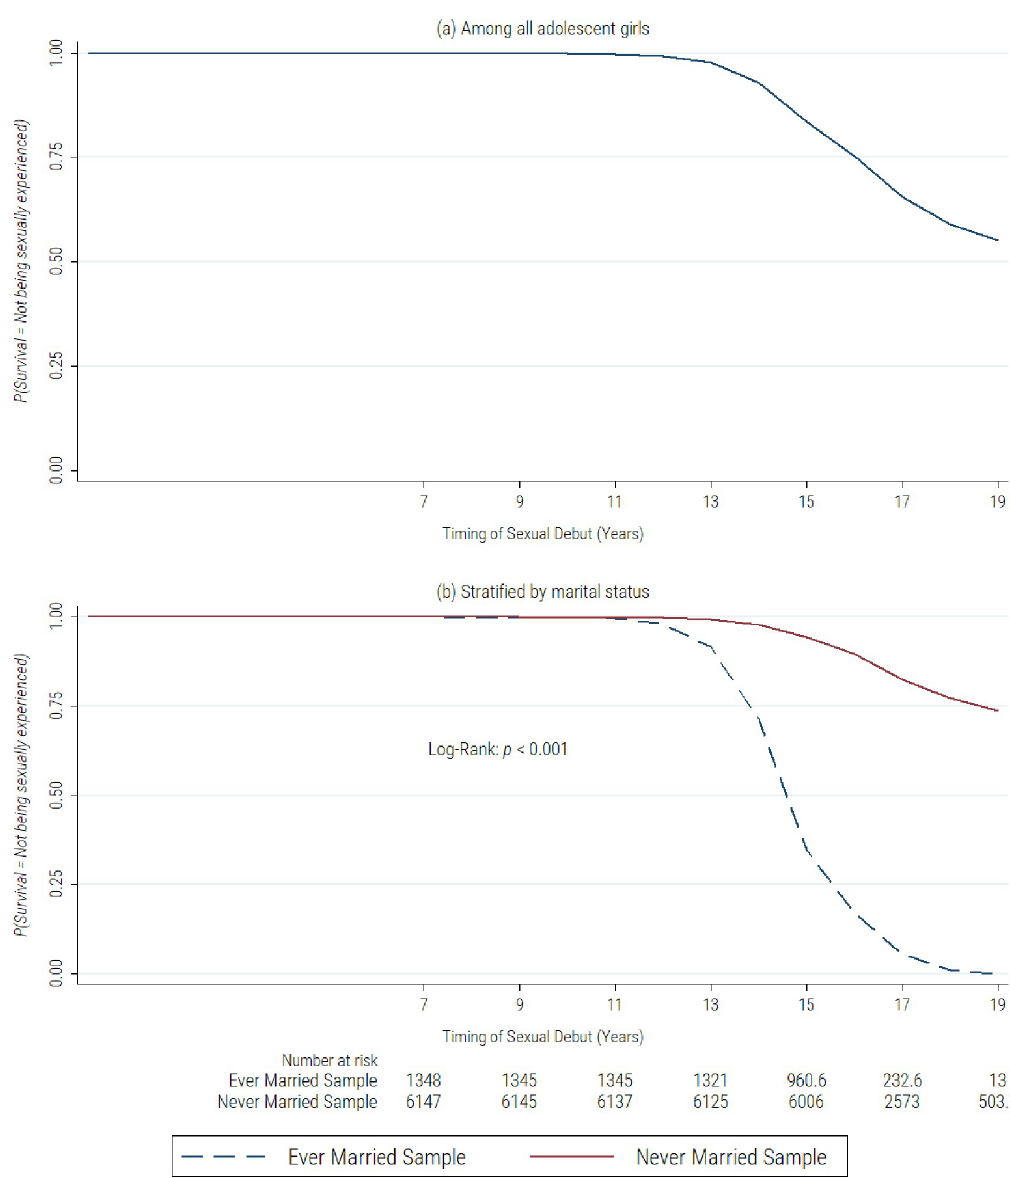
Fig 1. Survival probabilities of not being sexually experienced among adolescent girls in